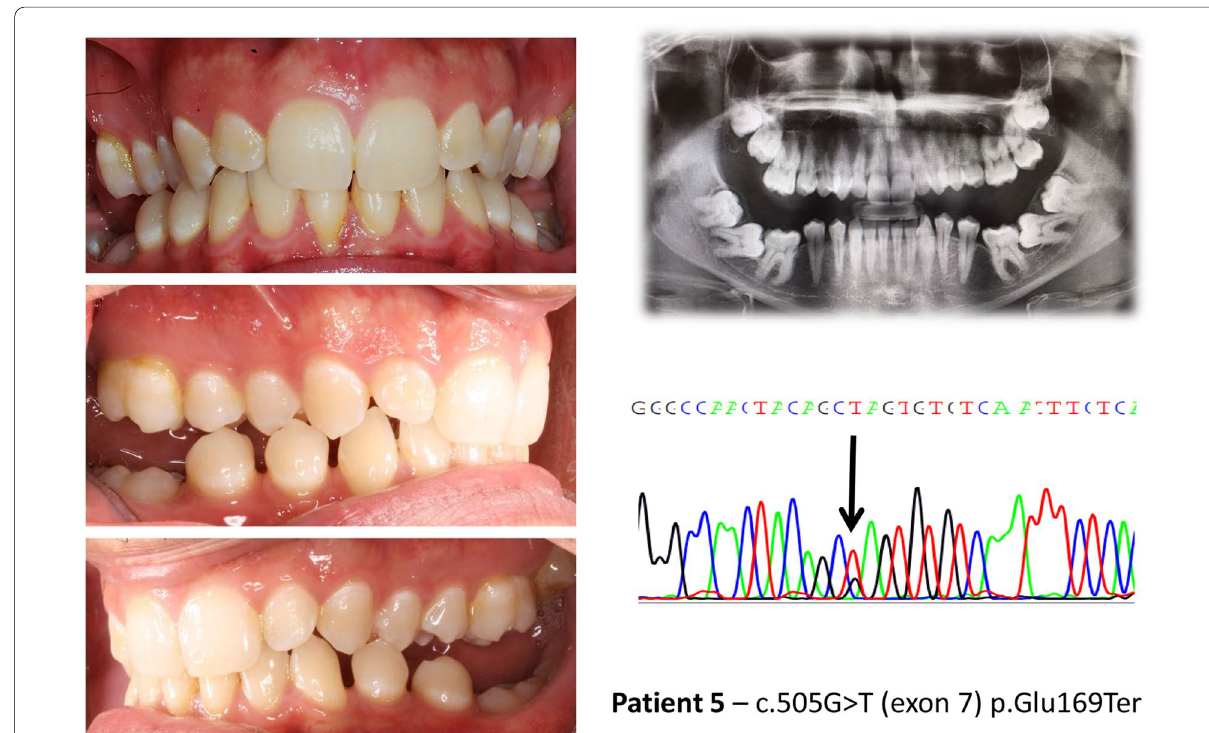
Fig. 1 Clinical features and genetic findings of patient 5 with PFE and a PTH1R nonsense variant